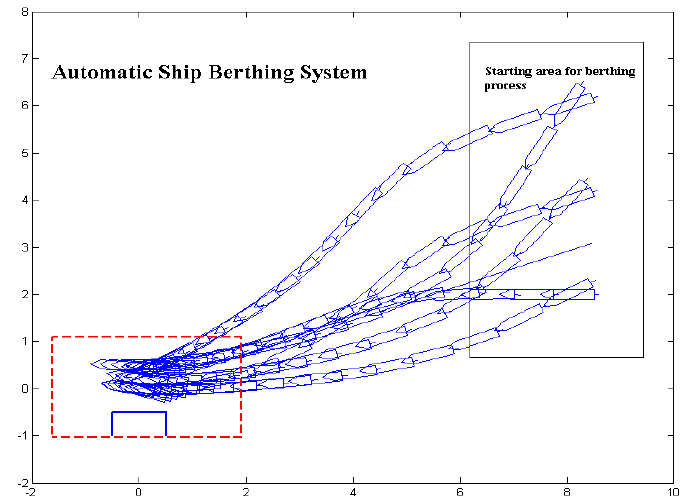
Figure 12. The automatic ship berthing system using neural network controller.